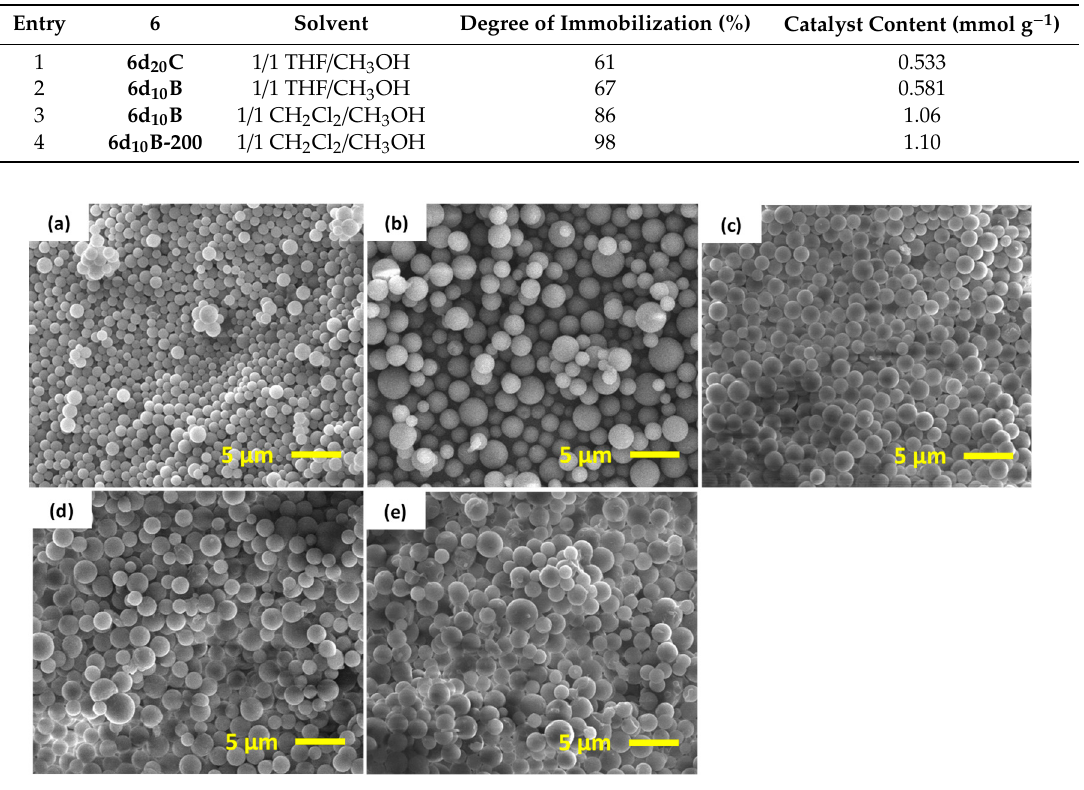
Figure 2. SEM images. ( a ) 1d 10 B , ( b ) 2d 10 B , ( c ) 3d 10 B , ( d ) 4d 10 B , and ( e ) 6d 10 B .